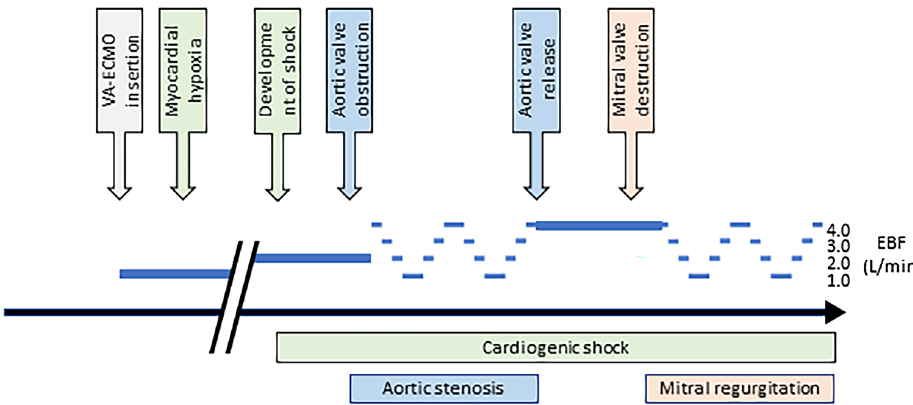
Figure 1. Schematic illustration of the experimental protocol. VA-ECMO, veno-arterial extracorporeal membrane oxygenation; EBF, extravascular blood flow.